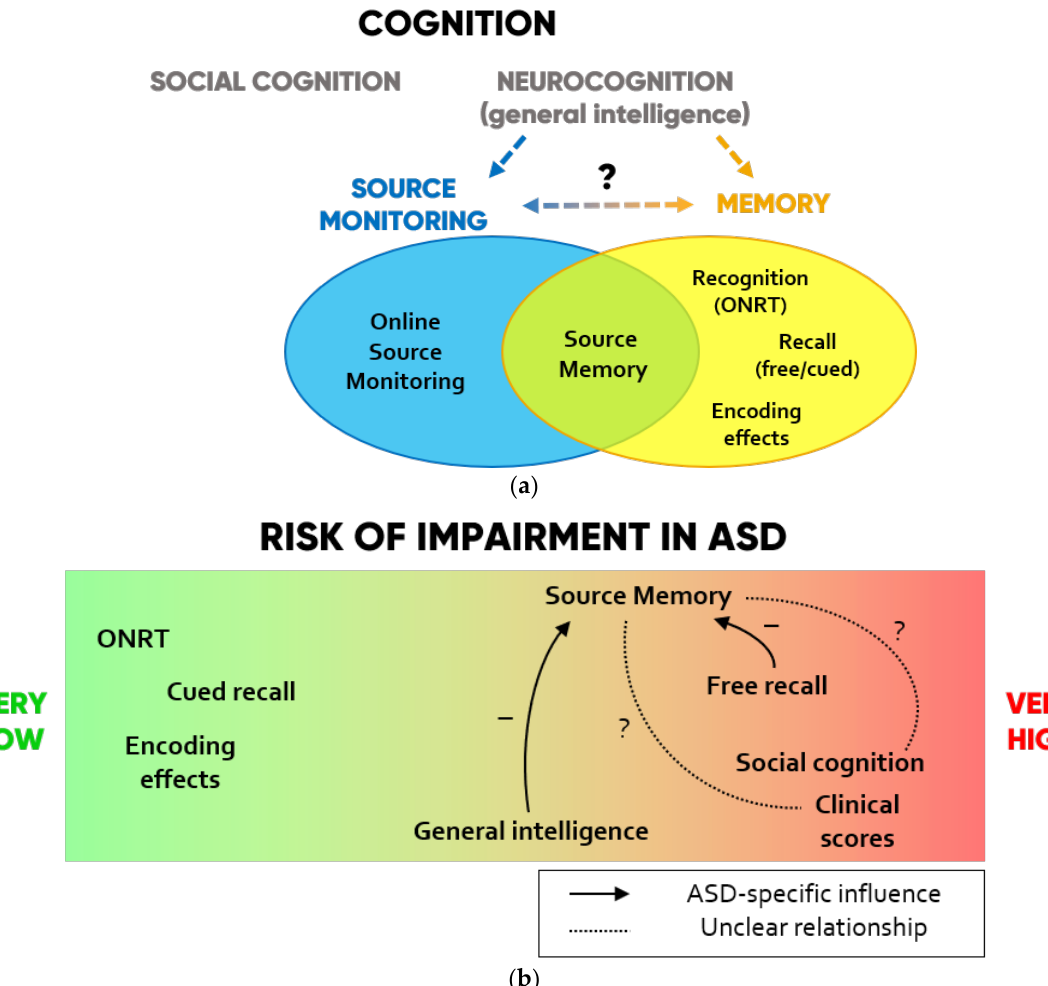
Figure 2. ( a ) Scheme of the cognitive domains investigated in SM studies in ASD. ( b ) Degrees to which each domain is impaired in ASD and hypotheses on ASD-specific influences that each function may exert on SM according to the collected findings.